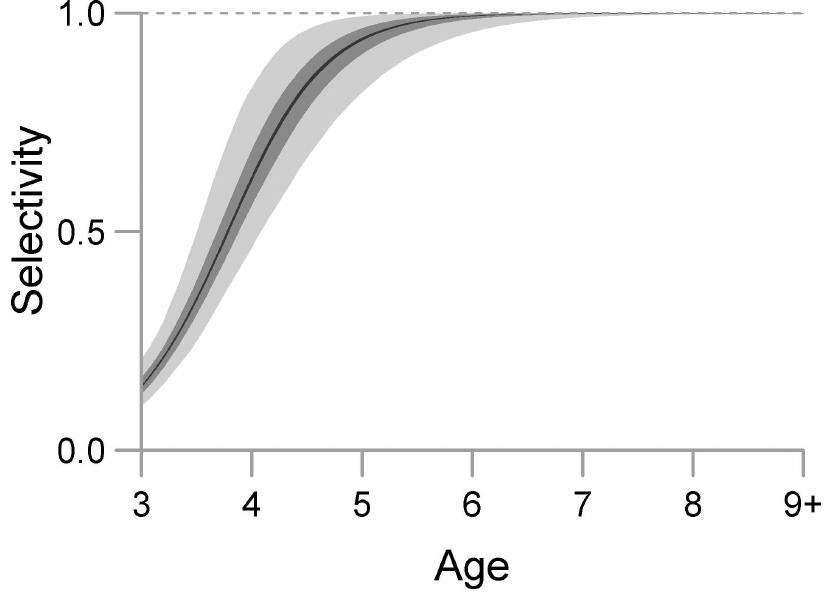
Fig 8. Posterior distribution (light gray = 2.5–97.5% interval, darker gray = 25–75%interval, black = median) for model estimatesof selectivity proportion at